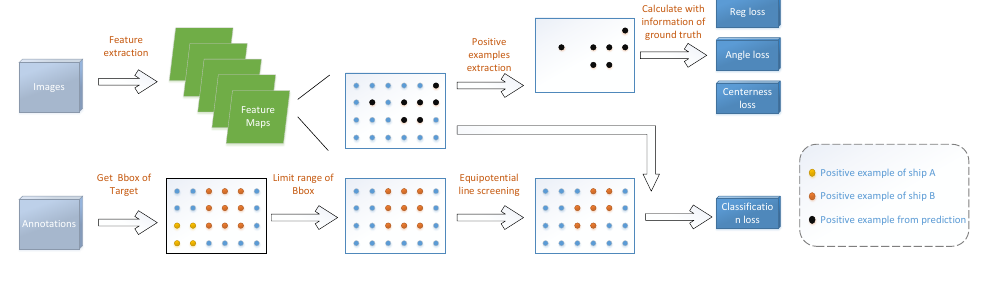
Figure 3. The process of positive sample